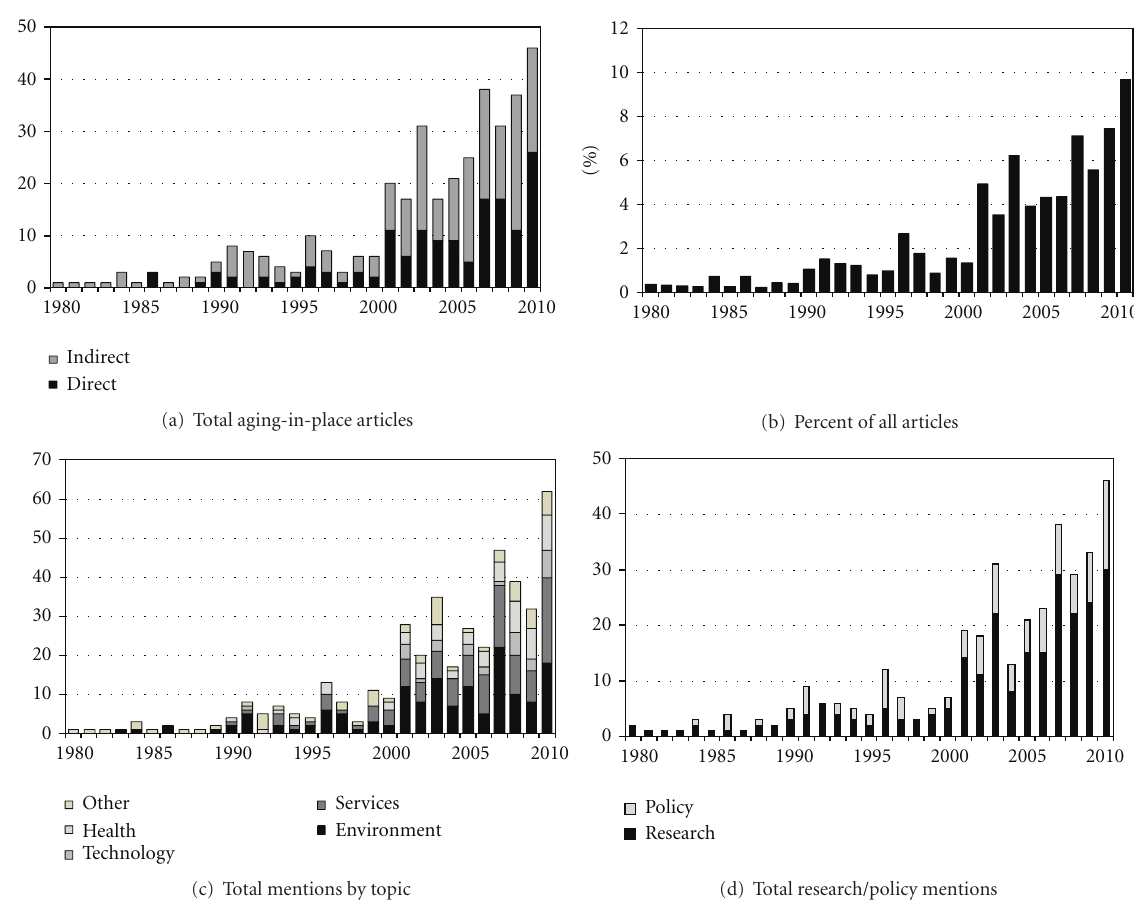
Figure 1: (a) Absolute number of aging-in-place articles (direct and indirect mention), 1980–2010; (b) proportion of aging-in-place articles relative to the total published articles, 1980–2010; (c) absolute number of categorical mentions among aging in place articles published, 1980–2010 ∗ ; (d) total aging in place articles by research/policy designation. ∗ Categorical mentions are not mutually exclusive (e.g., one manuscript may have multiple category